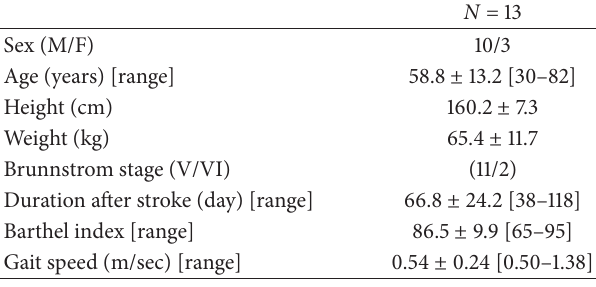
Table 1: General characteristics of stroke